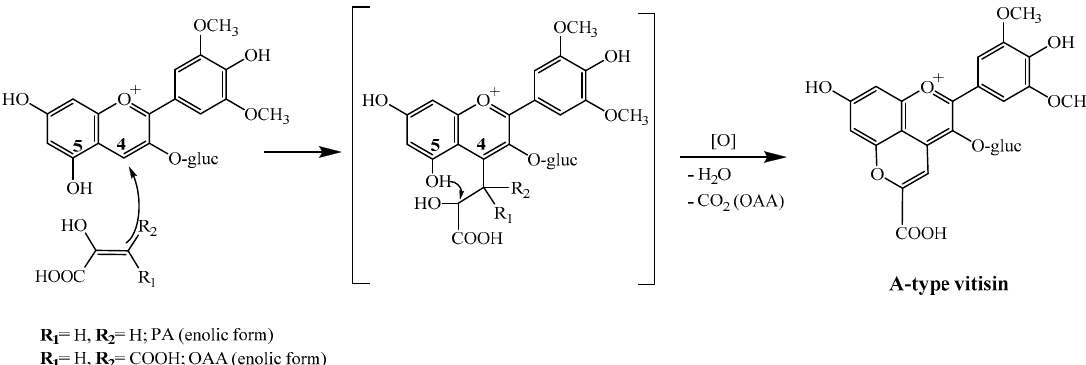
Figure 1. Mechanism of formation of A-type vitisin (carboxypyranomalvidin-3- O -glucoside) from pyruvic acid (PA) and oxaloacetic acid (OAA).